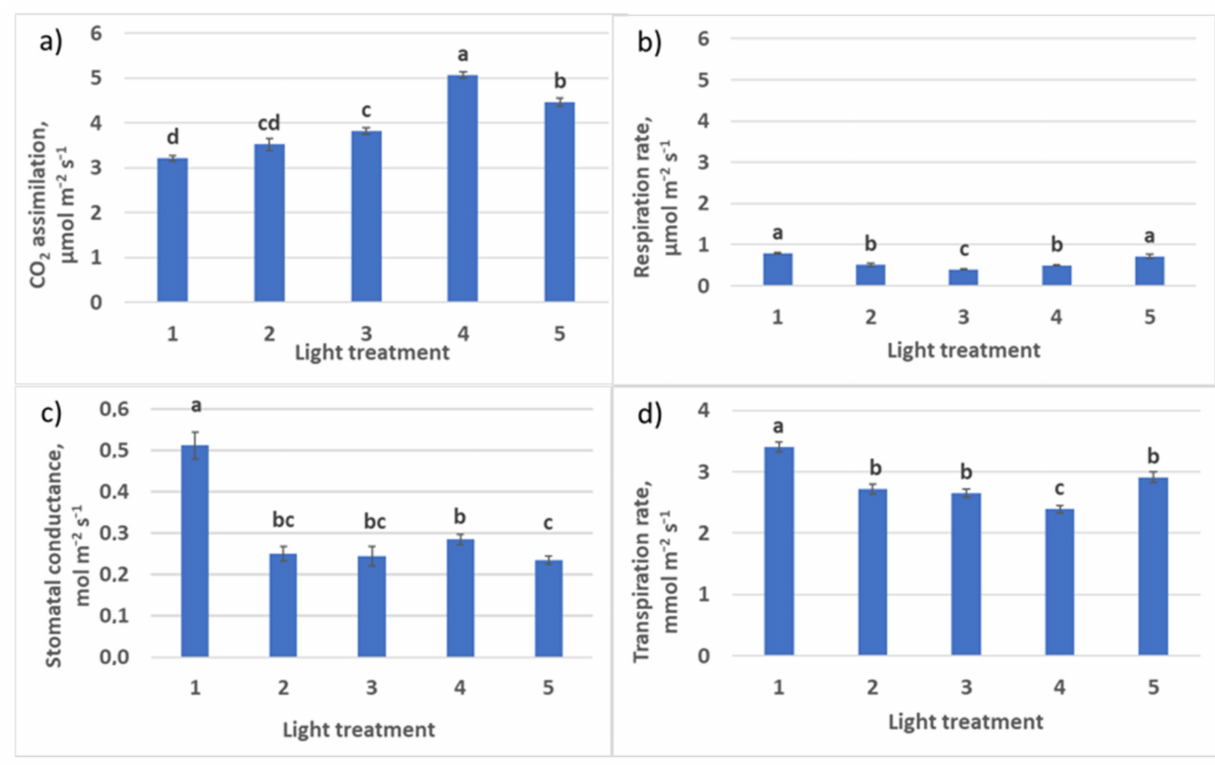
Figure 11. CO 2 –H 2 O leaf exchange in raspberry plants as affected by different red (R)–green (G)–blue (B) light ratio. ( a ) Net photosynthesis; ( b ) respiration rate; ( c ) stomatal conductance; ( d ) transpiration rate. Means ± standard error (SE); means followed by the same letter were not different at p ≤ 0.05. Treatment 1—50% R, 25% G, 25% B; Treatment 2—37% R, 26% G, 37% B; Treatment 3—24% R, 28% G, 48% B; Treatment 4—63% R, 16% G, 21% B; Treatment 5—46% R, 30% G, 23%